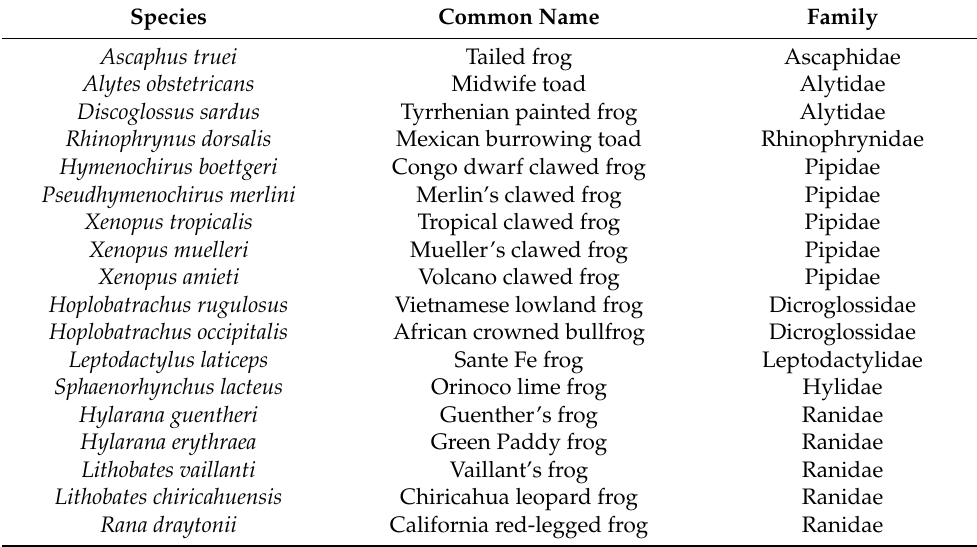
Table 1. Species, common names and families of the frogs from which immunomodulatory peptides have been